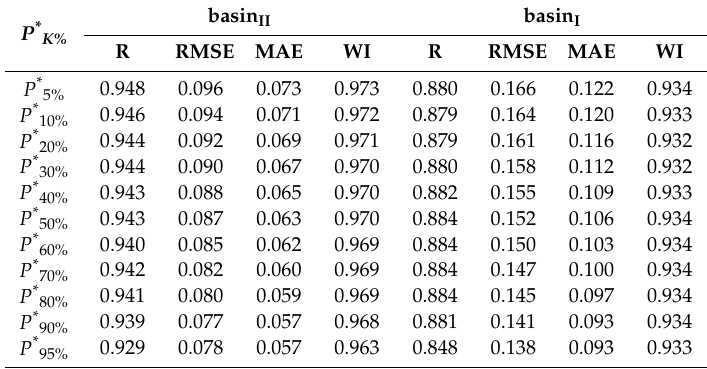
Table 7. Statistical criteria to estimate P * K% with di ff erent probabilities of occurrence.